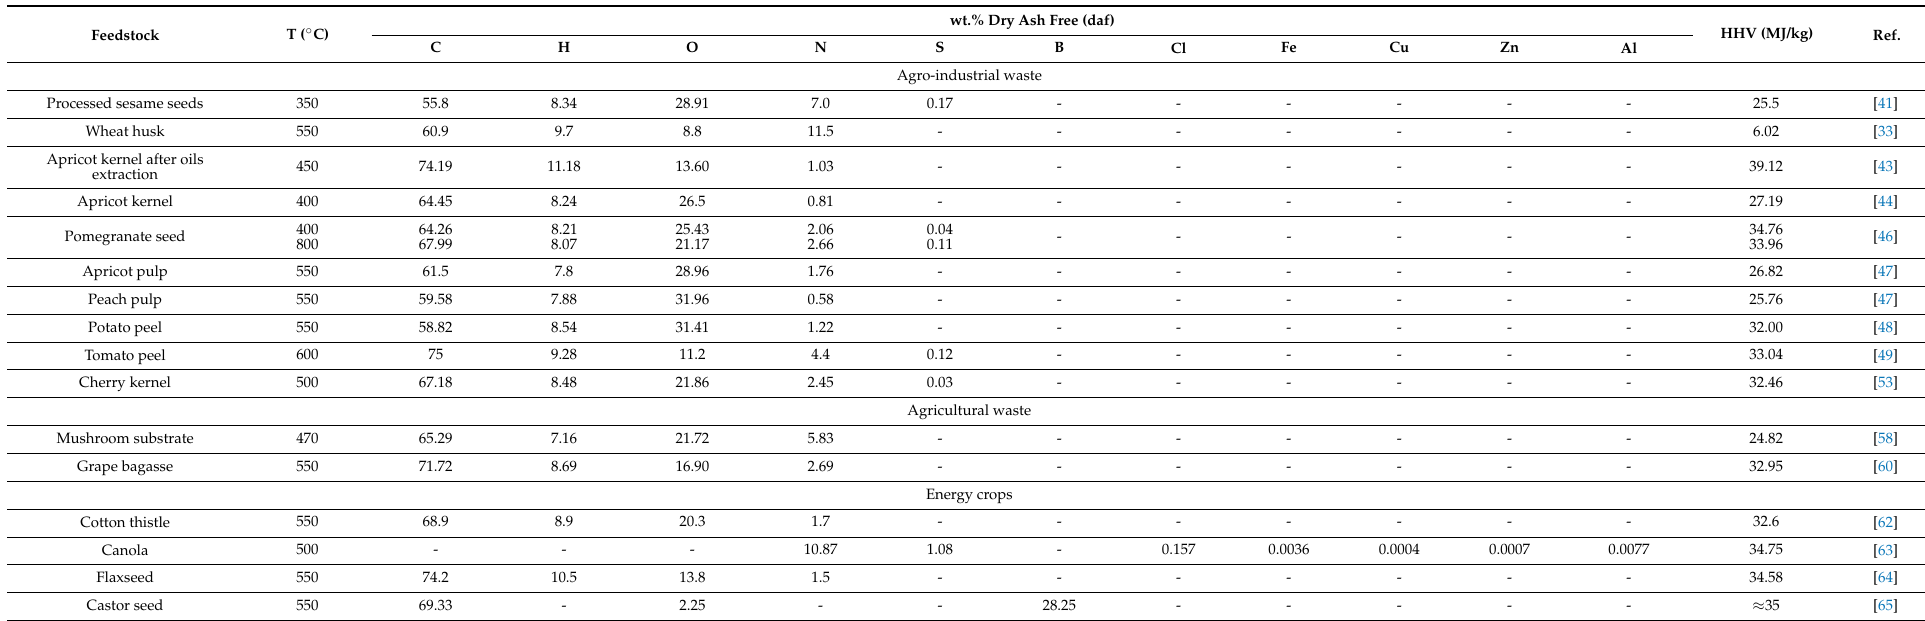
Table 7. Chemical composition of